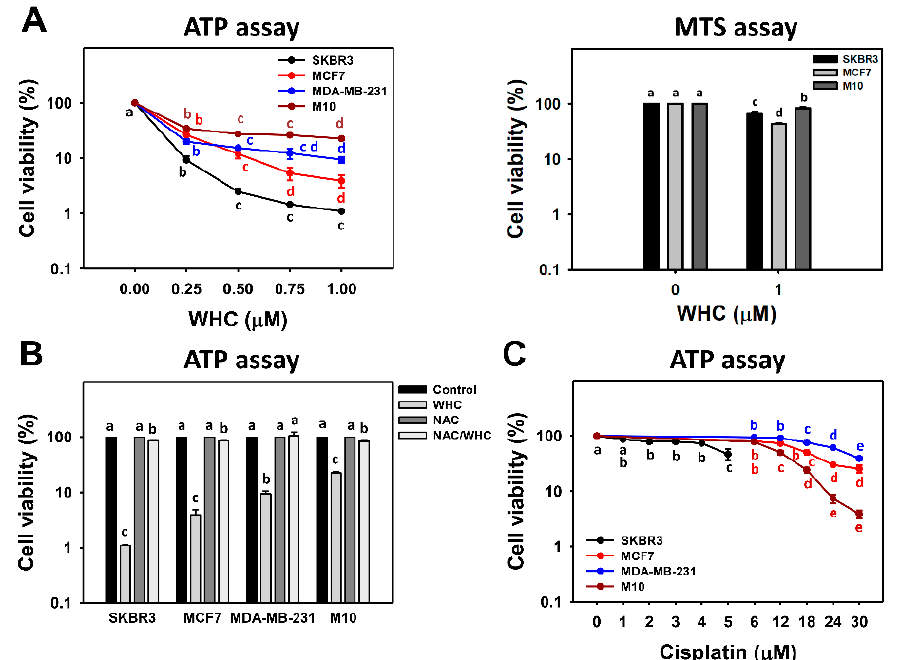
Figure 1. Withanolide C (WHC) inhibited the cell viabilities of breast cancer and normal breast cells differentially. Cell viabilities were determined by ATP assays. ( A ) ATP and MTS assays for determining cell viability after WHC treatment. For the ATP assay, breast cancer (SKBR3, MCF7 and MDA-MB-231) cells and breast normal (M10) cells were exposed to 0 (0.1% DMSO only), 0.25, 0.5, 0.75, and 1 µ M of WHC for 48 h. For the MTS assay, breast cancer (SKBR3 and MCF7) cells and M10 cells were exposed to